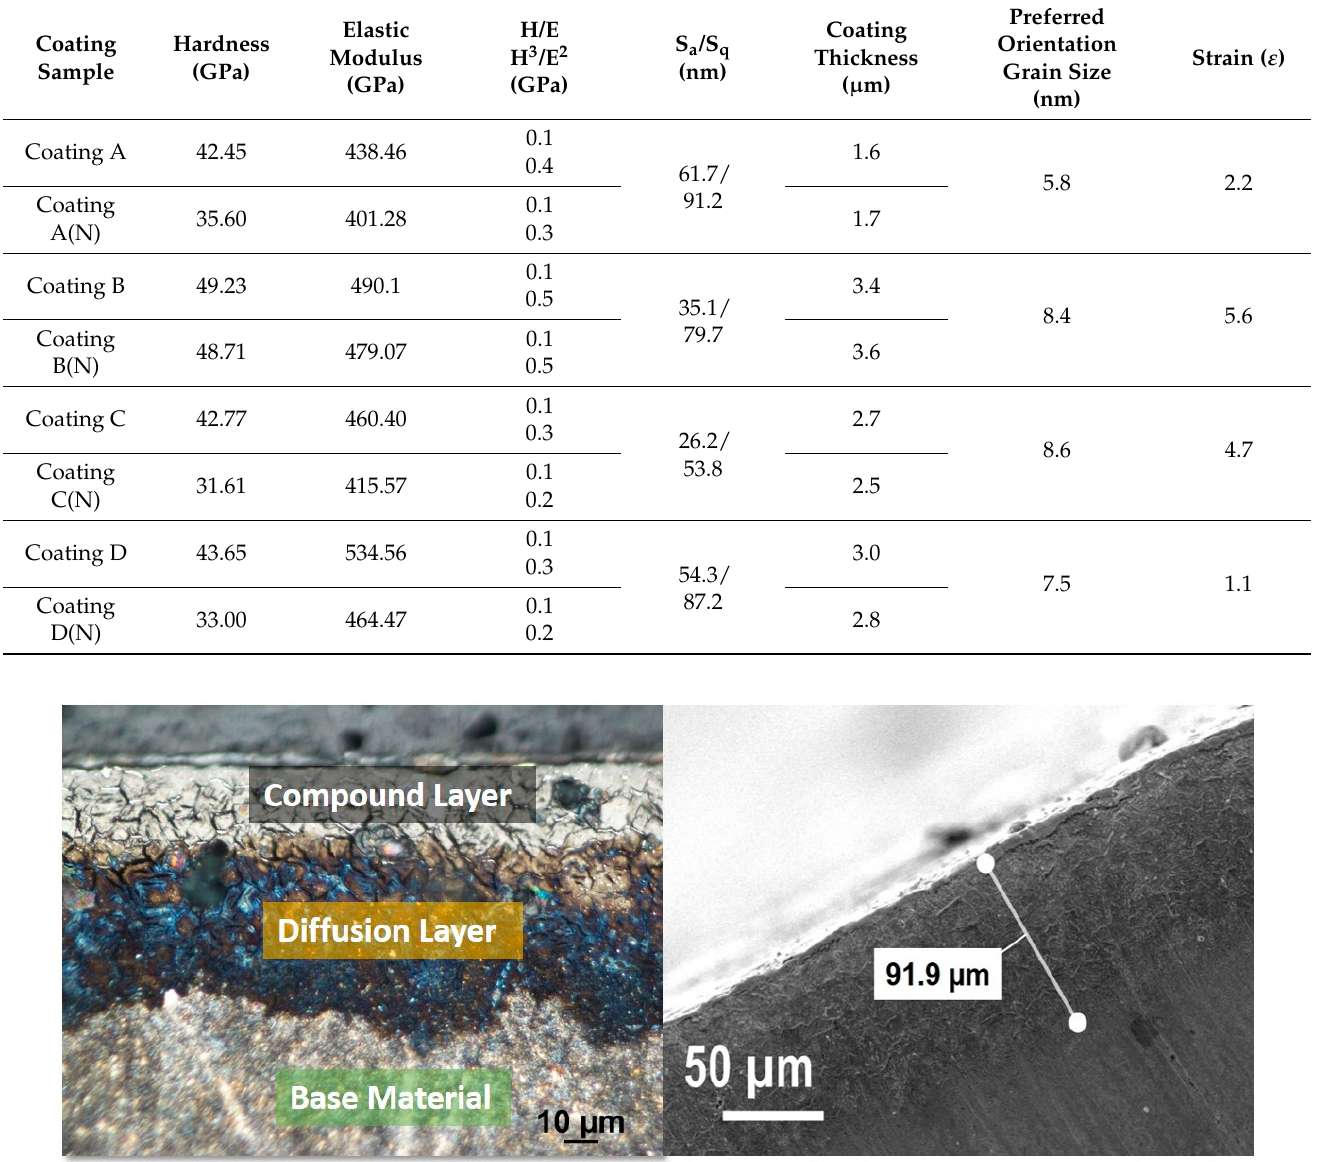
Figure 7. Results of adhesion testing, according to the ISO 26443:2008 standard.